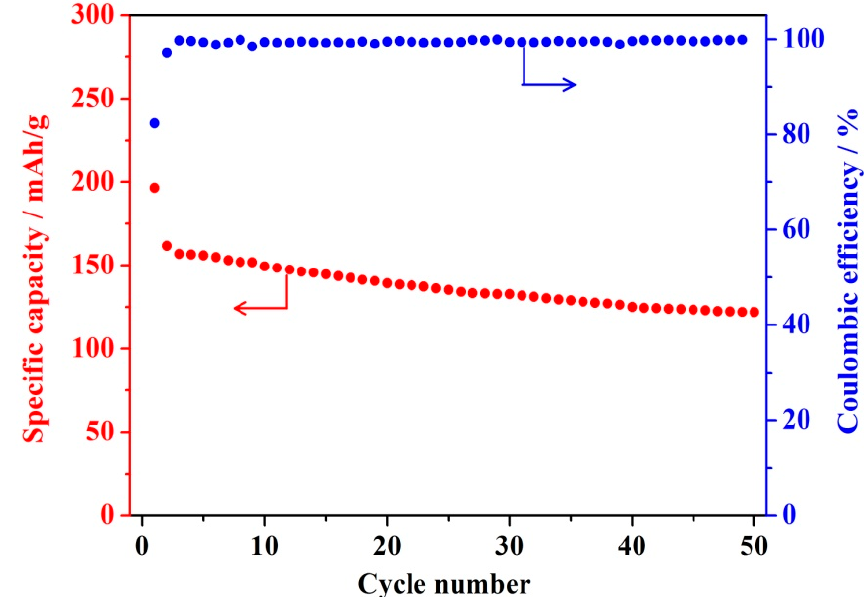
Figure 12. Cycling performance at the current density of 100 mA/g in 0.01–3 V.